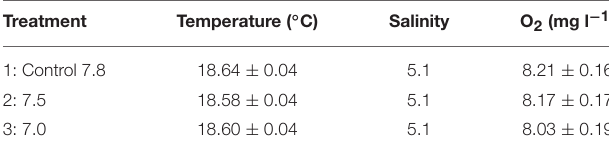
TABLE 2 | Mean ( ± S.E.) temperature, salinity and oxygen over the course of experiments with stickleback ( G. aculeatus ) eggs and larvae.